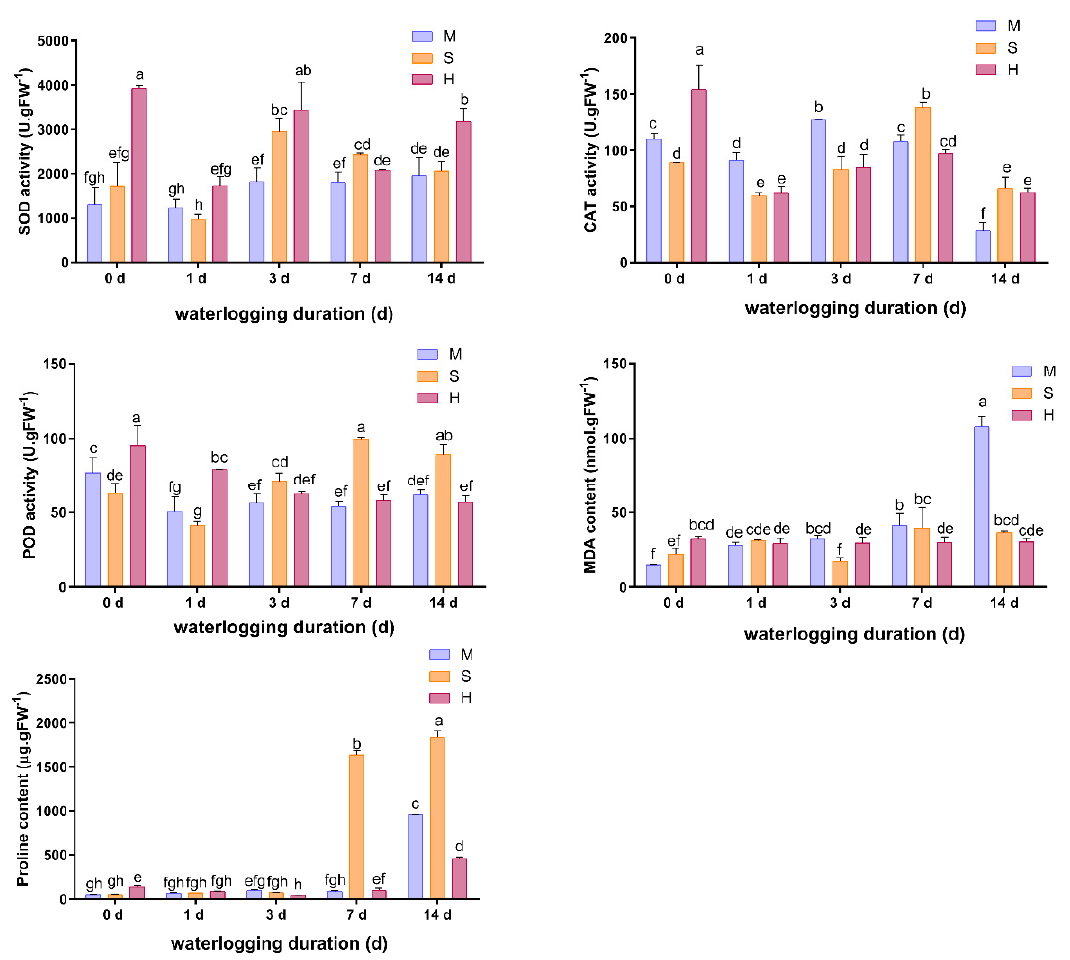
Figure 6. The comparison of the activities of antioxidant enzymes and content of MDA and proline of different peach rootstock seedlings under waterlogging stress. Abbreviations: M: Prunus persica, ‘Maotao’; S: Prunus davidiana, ‘Shantao’; H: ‘Hossu’. The data are the means ± SDs. Within columns, means with a different letter indicate significant differences ( p < 0.05) using Duncan’s test; bars on the columns represent the standard errors (SD) (n = 6).